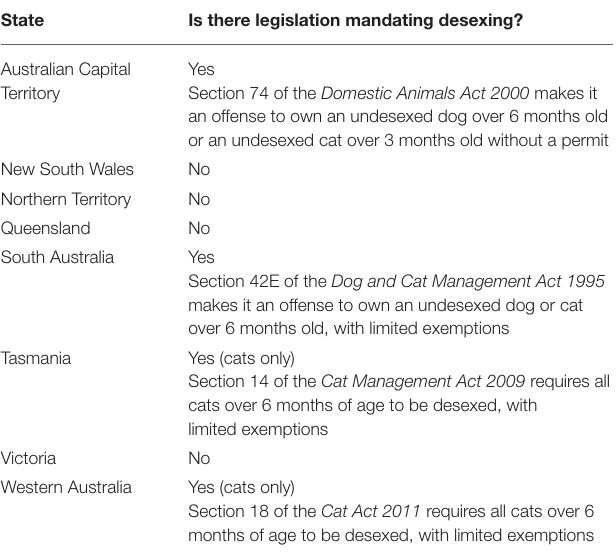
TABLE 1 | Details of mandatory desexing requirements in each state and territory of